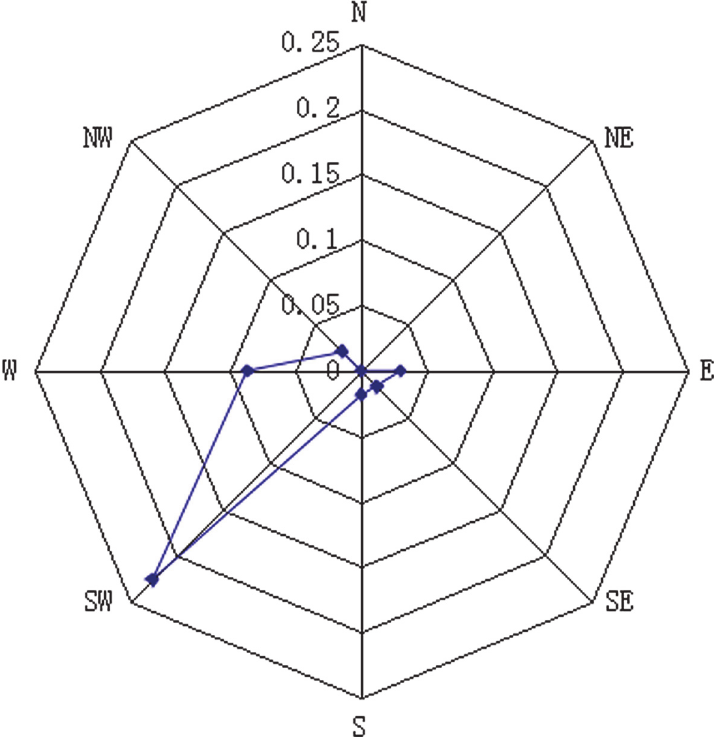
Fig 1. The distribution of the contamination factor. According to the meteorological data, southwesterly was the predominant wind direction in the 3 rd